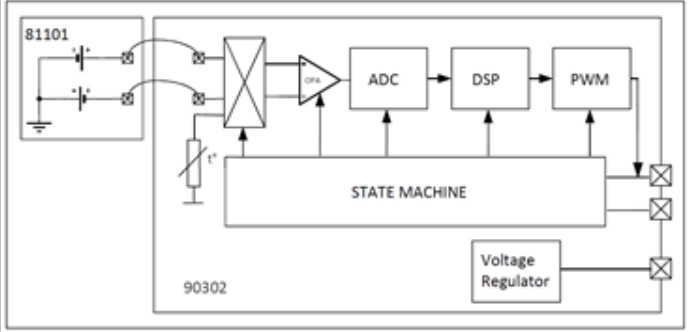
Figure 6. Block diagram of MLX90614.